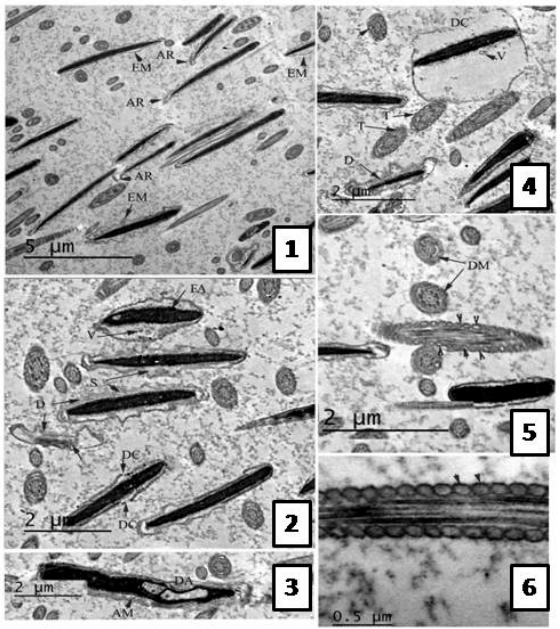
Figure 4. TEM photomicrographs of sagital sections of the bull sperm in control group representing different stages of damage after freezing—thawing process. ( 1 ) The plasma membrane is extended (EM) away from nucleus and apical ridge (AR) is formed near the tip of acrosomal cap (AC). ( 2 ) The plasma membrane at acrosomal region and sub acrosomal region detached from the nuclear envelop leaving sub-membranous swelling (S) and vesiculations (V) appears inside degenerated cell membrane (D). Discontinuous membrane (DC) is also noted in addition to flat acrosome (FA). ( 3 ) The section revealed a marked damage of acrosomal cap (DA), cell membrane and diffusion of acrosomal dense material (AD) into the previously formed space. ( 4 and 5 ) Different sections of neck region show abnormal mitochondrial sheath. Unequal size and distribution (arrow heads), electron translucent (T) and degenerated mitochondria (DM) were also detected. ( 6 ) Longitudinal section for mitochondrial sheath show amorphous material of mitochondria (arrow heads), absence of cristae and cell membrane.